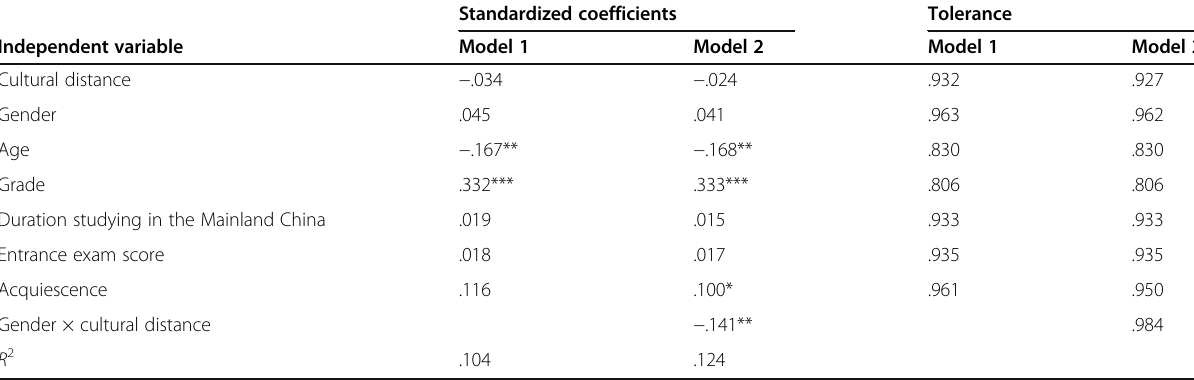
Table 3 Regression analysis of academic